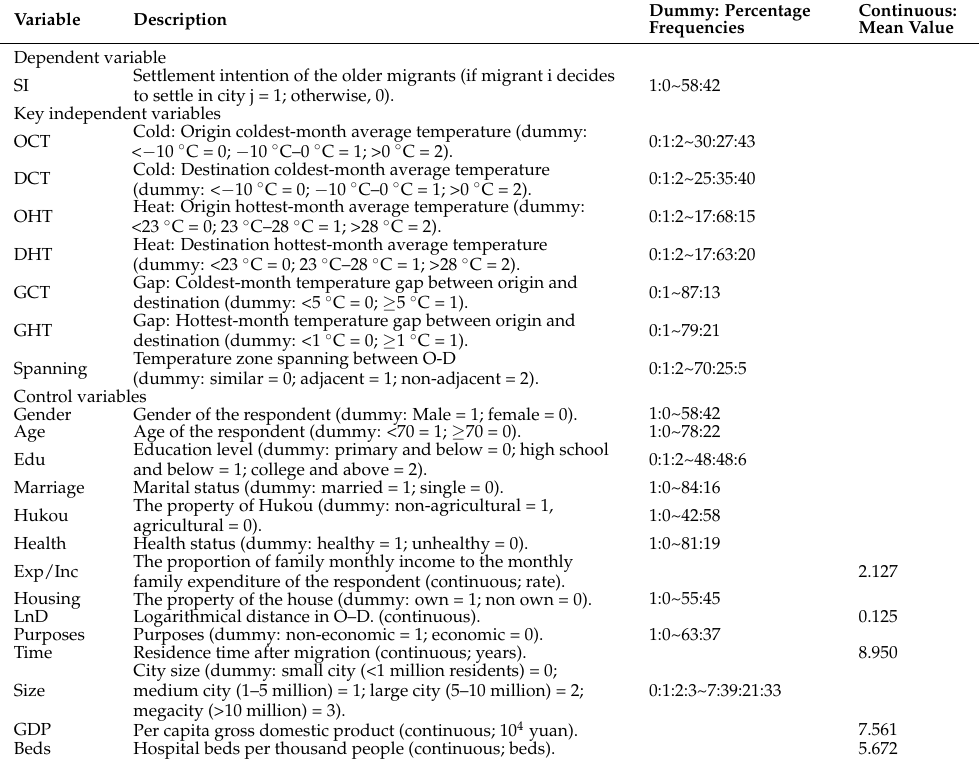
Table 1. Definitions and descriptive statistics of